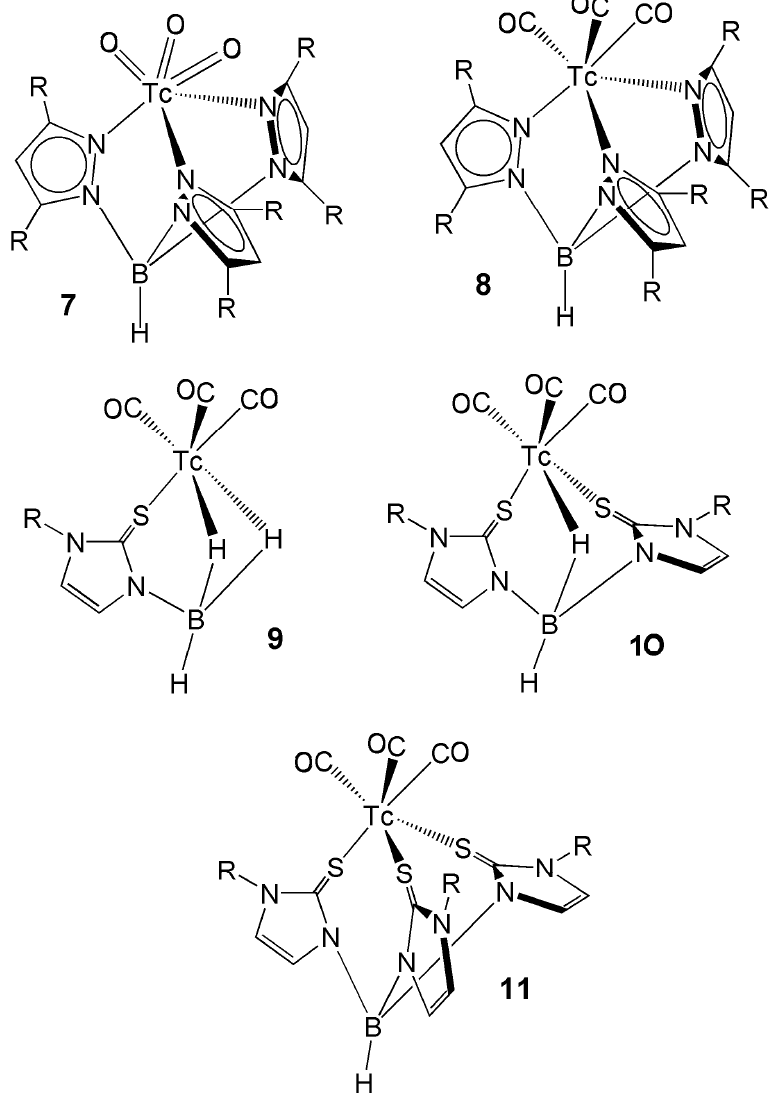
Figure 4. Schematic drawings of the chemical structures of the most important families of technetium scorpionate complexes. [Tc(O 3 )HB(R 2 pz) 3 ] ( 7 ), [Tc(CO) 3 HB(R 2 pz) 3 ] ( 8 ), [Tc(CO) 3 H 3 B(Rmz)] ( 9 ), [Tc(CO) 3 H 2 B(Rmz) 2 ] ( 10 ), [Tc(CO) 3 HB(Rmz) 3 ] ( 11 ).